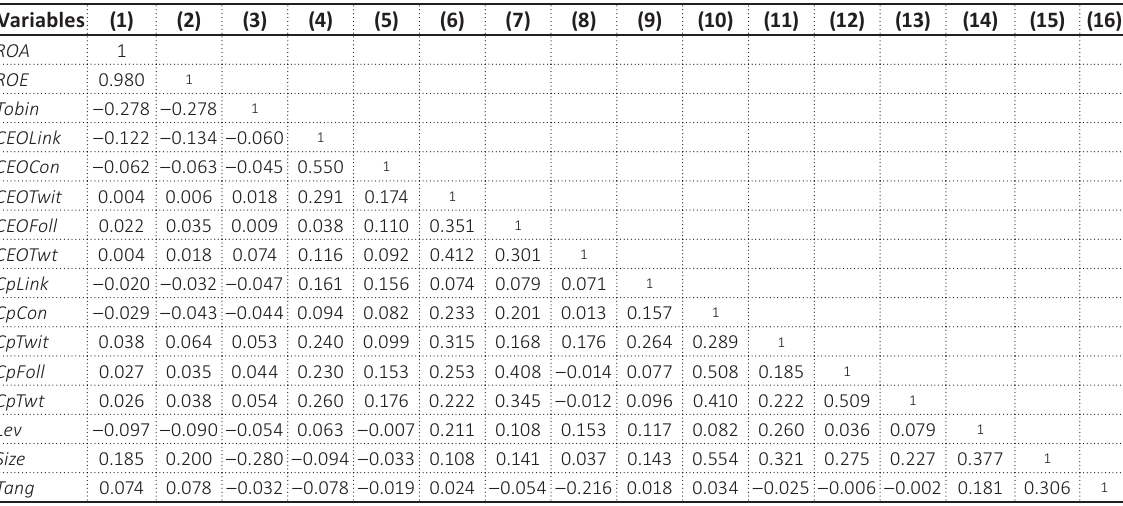
Table 4. Correlation